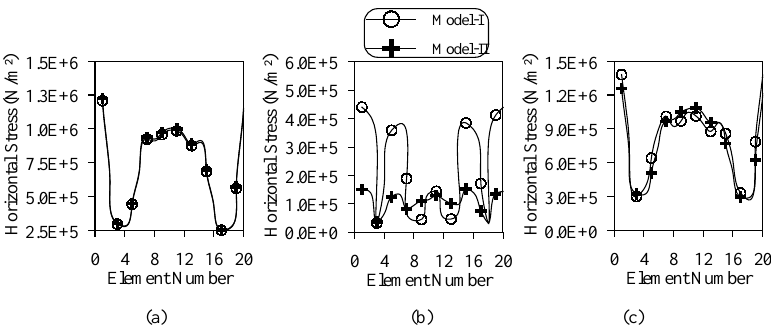
Fig.9. Mean of maximum (a) quasi-static, (b) dynamic and (c) total displacements for the Kocaeli earthquake in 1999, respectively.